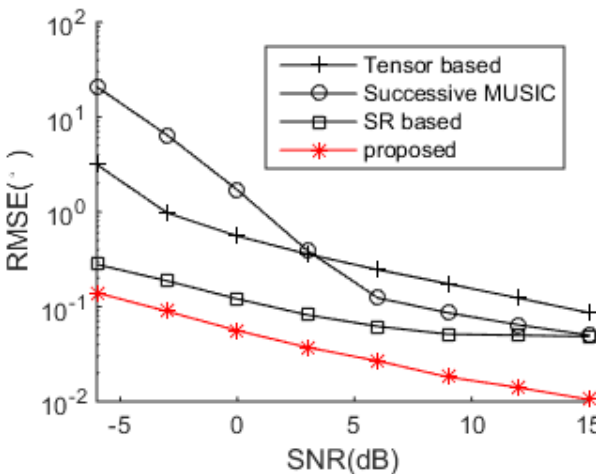
Figure 10. DOA estimation performance comparison with non-uniform spatial noise.